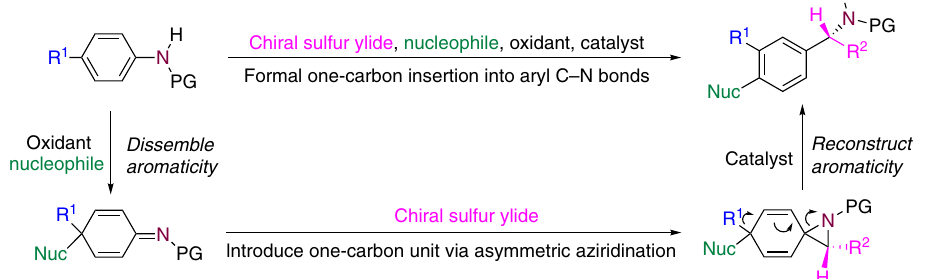
Fig. 2 Formal one-carbon insertion into aromatic carbon – nitrogen bonds. The transformation might proceed via a dearomatization of para -substituted anilines, an chiral sulfur ylides-mediated asymmetric aziridination, followed by a rearrangement to recover the aromaticity and complete the formal enantioselective one-carbon insertion accompanied by a migration of the para -substituent to the meta position and para -substitution by a nucleophilic reagent. PG protecting group, Nuc nucleophile.